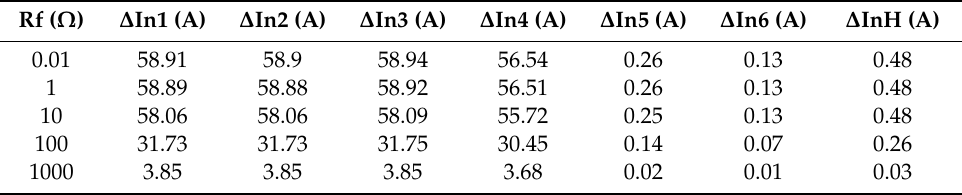
Table 2. Negative sequence currents in urban isolated network.